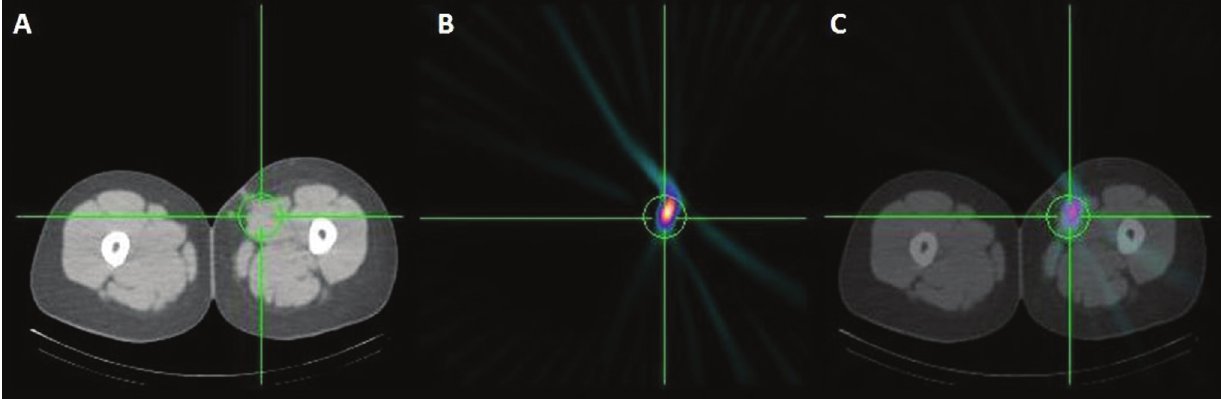
Figure 5 - SPECT-CT carried out after Sn- 99m Tc injection in the left abdominal lesion. A) Anatomical image. B) Metabolic image. C) Fusion of the two